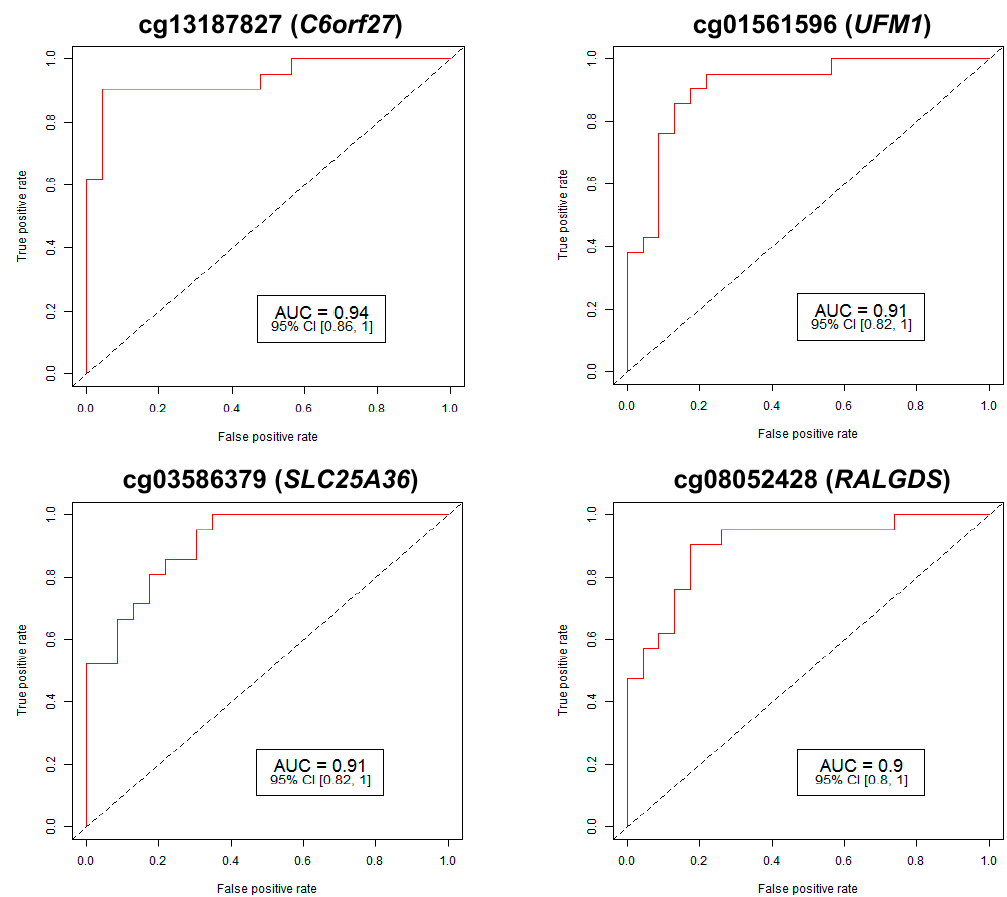
Figure 1. Receiver operating characteristic (ROC) curve analysis of methylation summaries for four specific markers linked with CP. The study identified 230 differentially-methylated CpG sites in 258 genes that have an area under the ROC curve ≥ 0.75 ( p -value ≥ 0.05) for CP prediction. AUC: area under the receiver operating characteristics curve; 95% CI: 95% confidence interval. Lower and upper confidence intervals are given in parentheses.